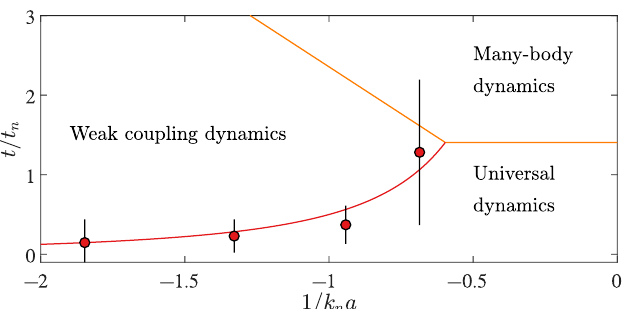
Figure 1. Regimes of impurity dynamics. Characteristic regimes of impurity dynamics as a function of the inverse interaction strength 1/ k n a (see text) and the evolution time t / t n (see text). Solid lines indicate predicted transitions between the dynamical regimes. Red data points are experimentally extracted transition times and errors correspond to fit uncertainties. A similar figure was presented in Ref.